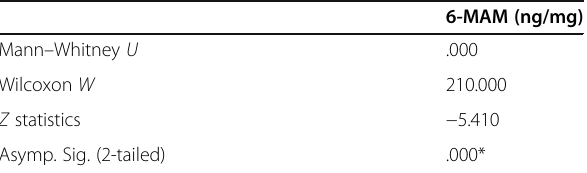
Table 7 Mann – Whitney U test statistics